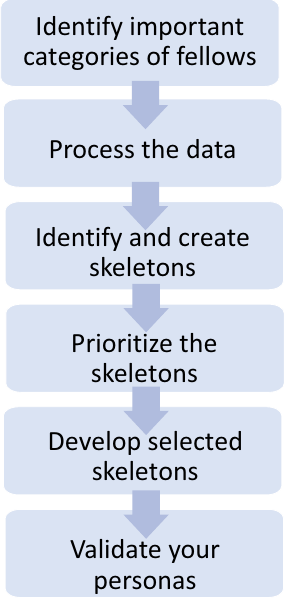
Fig. 1 Overview of persona development. Six steps in the development of the personas. (Modified from